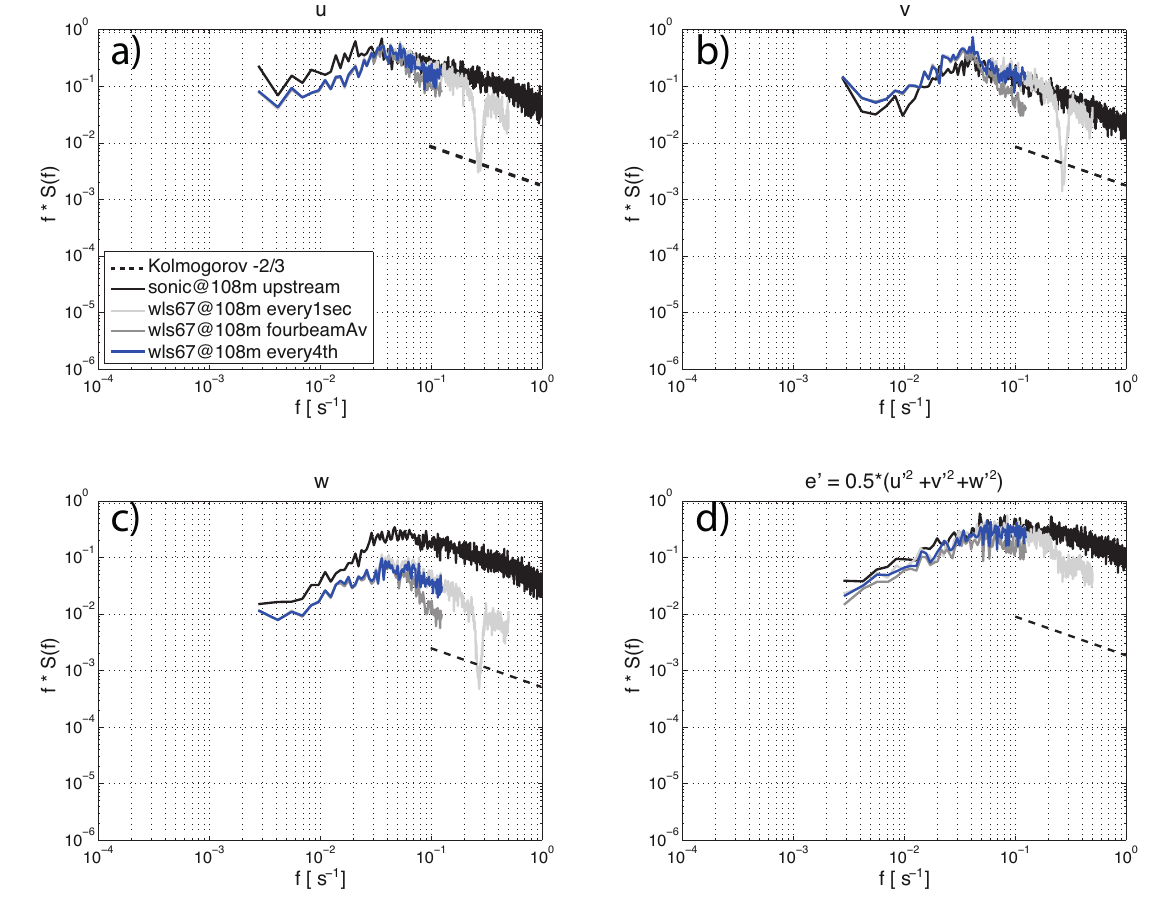
Figure 3. Energy spectra of four hours on 1 March 2014 during wake conditions ( dir mean = 60 ◦ ) of the along-wind ( a ), cross-wind ( b ) and vertical component ( c ) and TKE ( d ). Black and blue colors show wake data from the sonic anemometer and Windcube wls67 at 108 m. The dashed line indicates the − 2/3 Kolmogorov